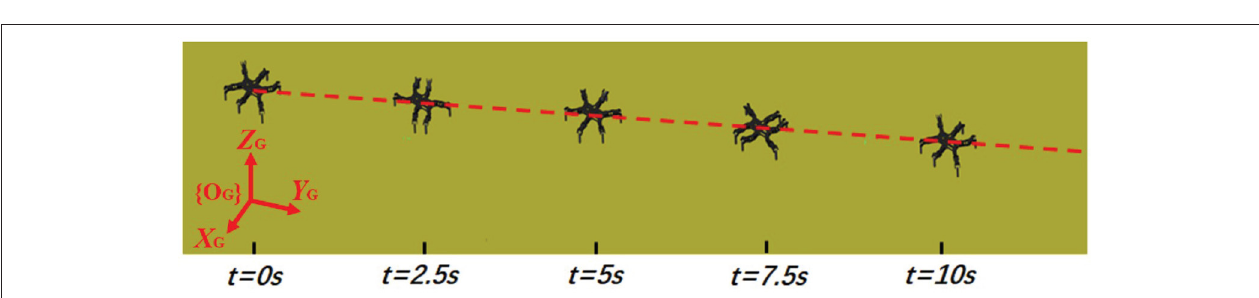
FIGURE 8 | The RL training simulation in an episode.